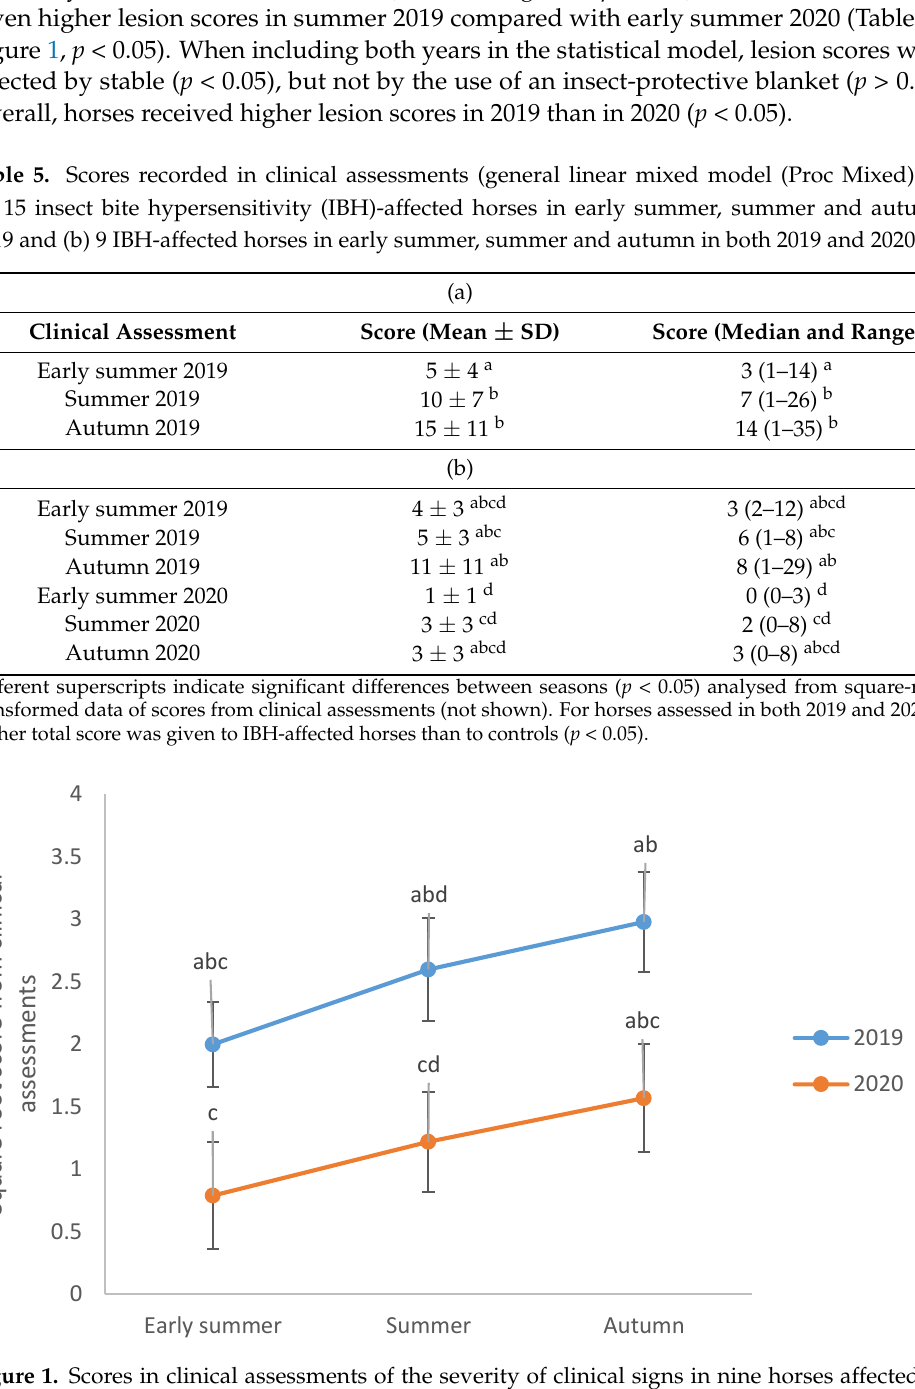
Figure 1. Scores in clinical assessments of the severity of clinical signs in nine horses affected by insect bite hypersensitivity (IBH) in early summer, summer and autumn 2019 and 2020. Values shown (square-root-transformed) are least square mean ± standard error. Different letters (a–d) indicate significant differences between seasons. Overall, horses received higher scores in 2019 compared with 2020 ( p < 0.05).